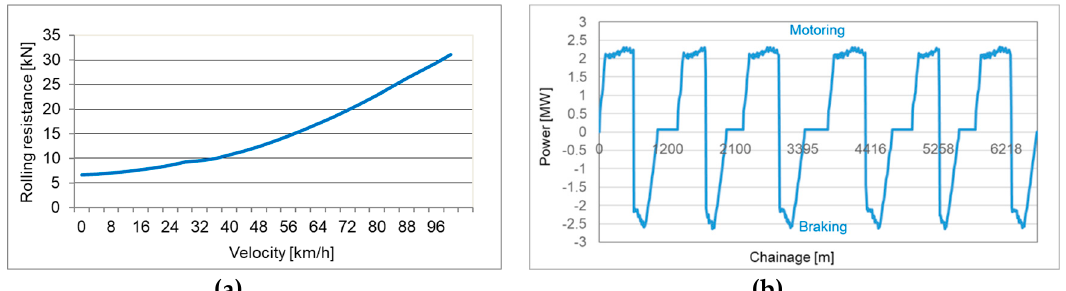
Figure 4. Simulation results for a train with no ESD: ( a ) Train rolling resistance, ( b ) Train power (positive power—the train is motoring, negative power—the train is braking with energy regeneration).